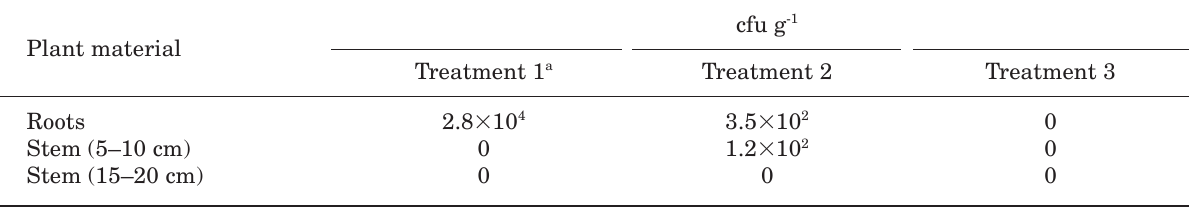
Table 1. Concentration of B49c/83 Rif + strain (cfu g -1 ) in peach seedlings detected with dilution plating.